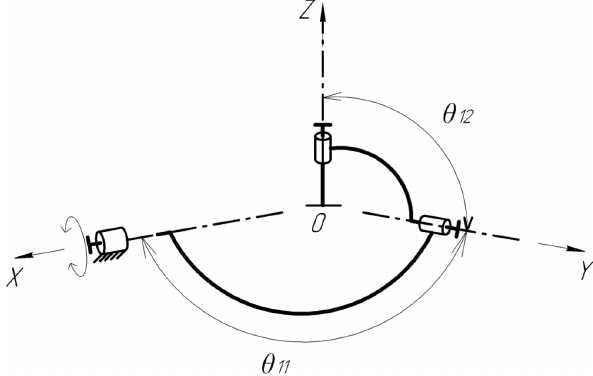
Figure 2. Angles between the axes of kinematic pairs θ 11 , θ 22 in the first kinematic